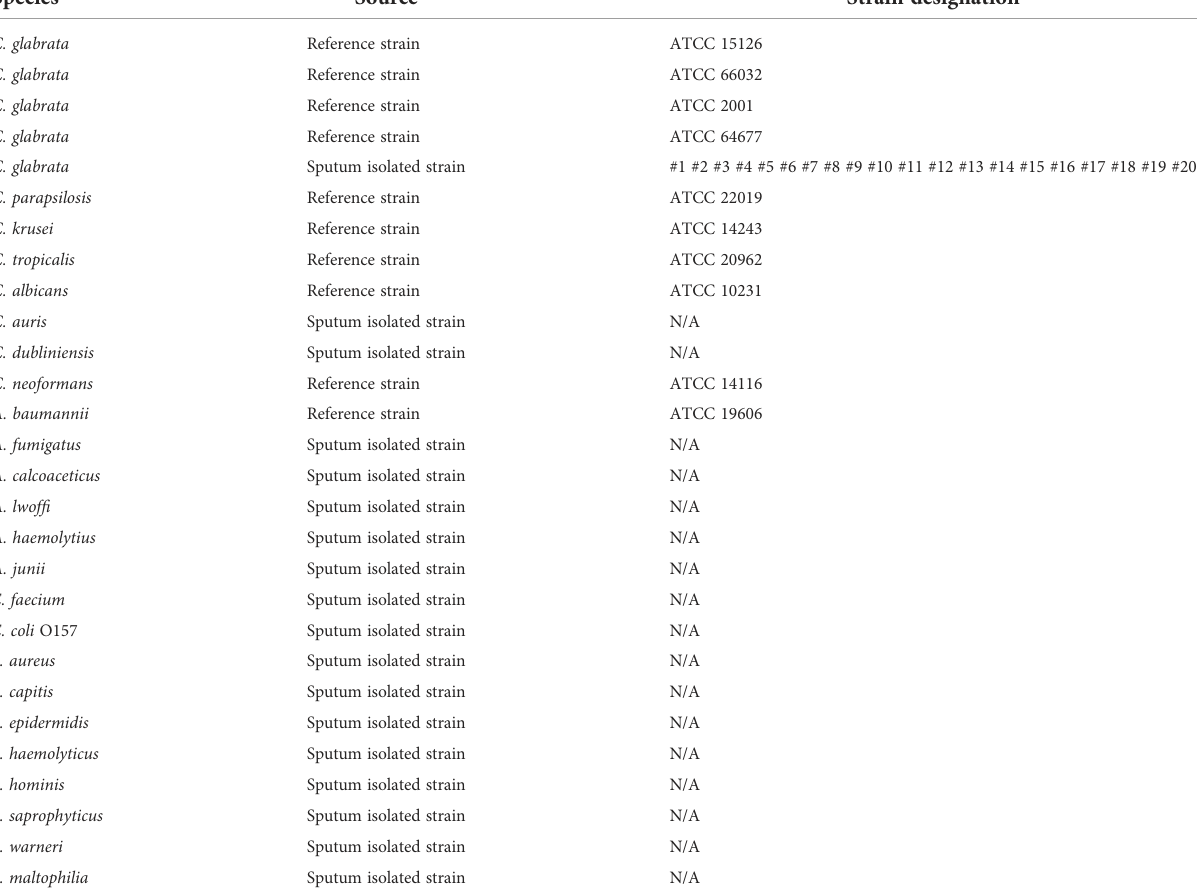
TABLE 2 Bacterial strains used in this